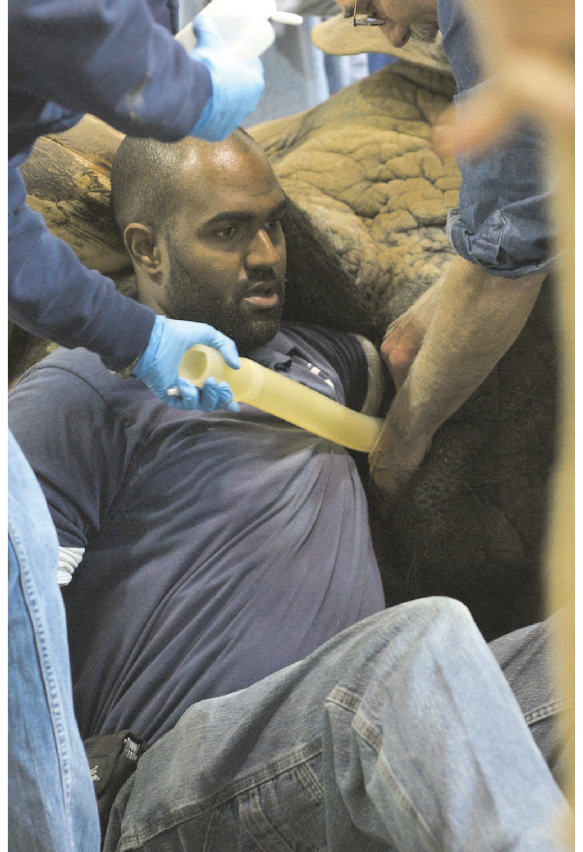
Figure 4: A size 30 endotracheal tube is being placed, under manual control, along the left arm of this